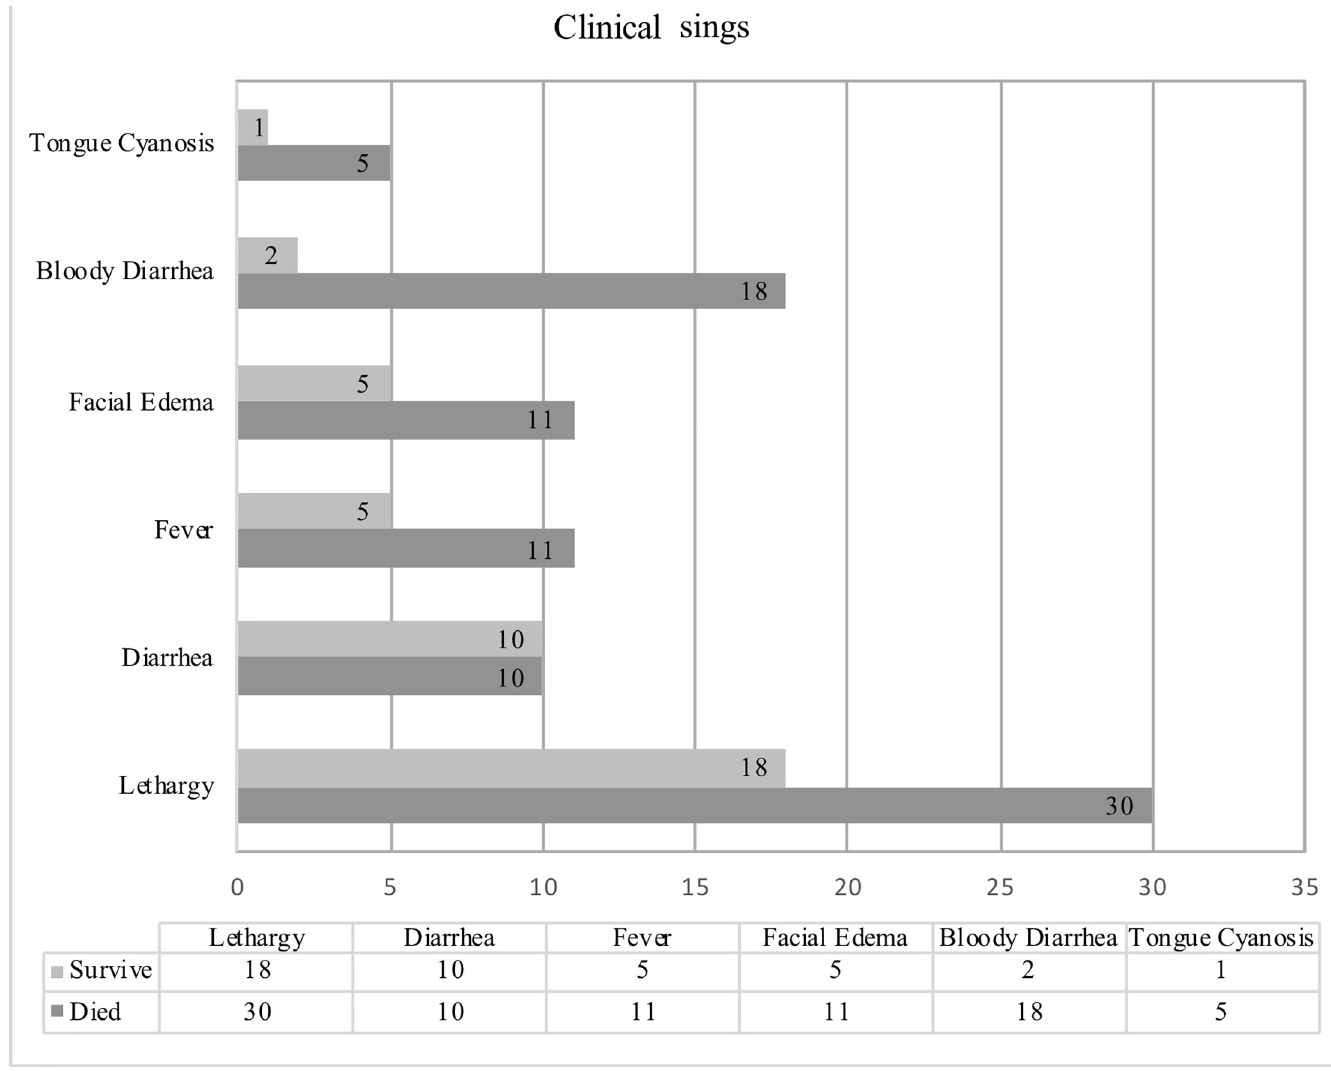
Fig 2. Presentation of clinical features in EEHV confirmed